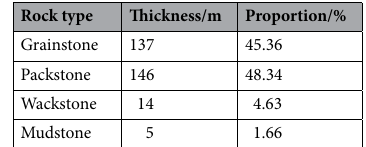
Table 1. Statistics of rock types of Mishrif Formation.